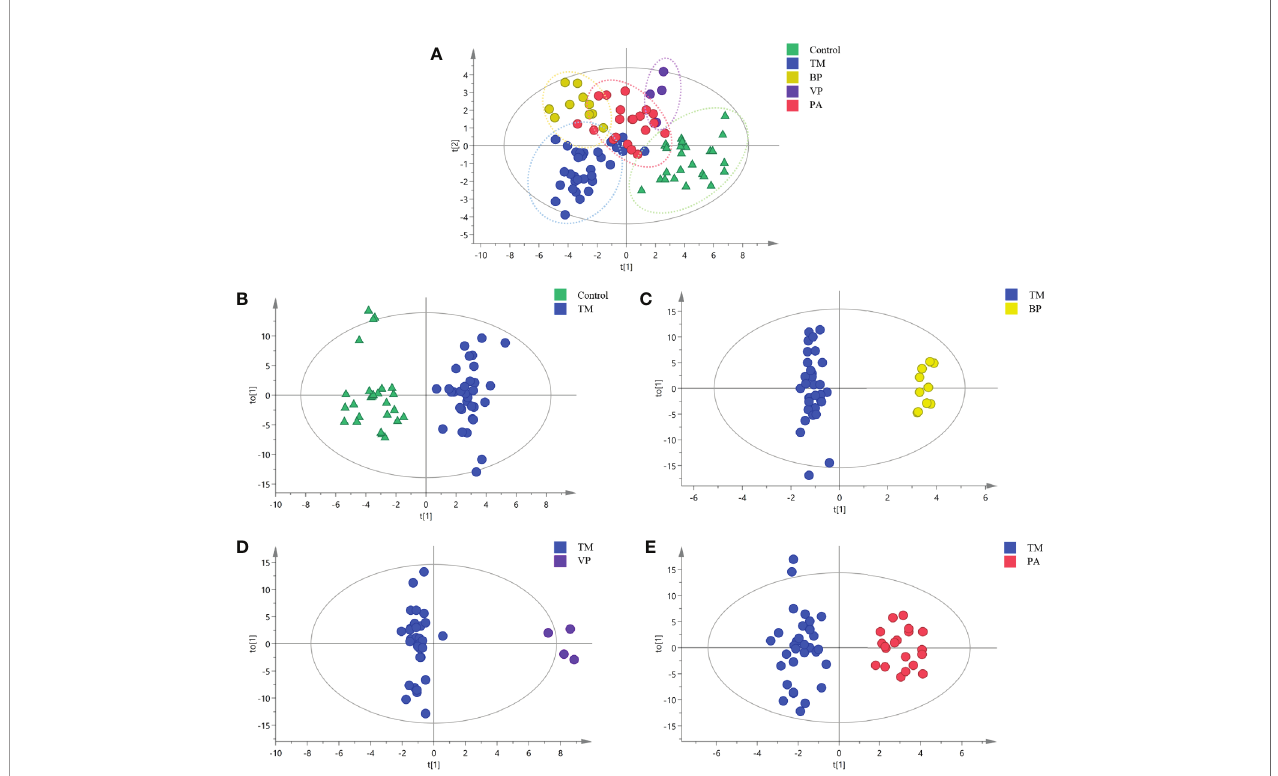
FIGURE 2 | Orthogonal partial least squares discriminate analysis (OPLS-DA) score plots for discriminating (A) all the sample groups, including healthy controls (Control group) ( n = 26), and patients with T. marneffei infection (TM group) ( n = 32), with bacterial pneumonia infection (BP group) ( n = 10), with viral pneumonia infection (VP group) ( n = 4), and with pulmonary aspergillosis infection (PA group) ( n = 20) (R 2 X = 0.869, R 2 Y = 0.679, Q 2 = 0.455); (B) TM group and Control group (R 2 X = 0.805, R 2 Y = 0.909, Q 2 = 767); (C) TM group and BP group (R 2 X = 0.836, R 2 Y = 0.981, Q 2 = 0.881); (D) TM group and VP group (R 2 X = 0.804, R 2 Y = 0.973, Q 2 = 0.836); and (E) TM group and PA group (R 2 X = 0.769, R 2 Y = 0.926, Q 2 =